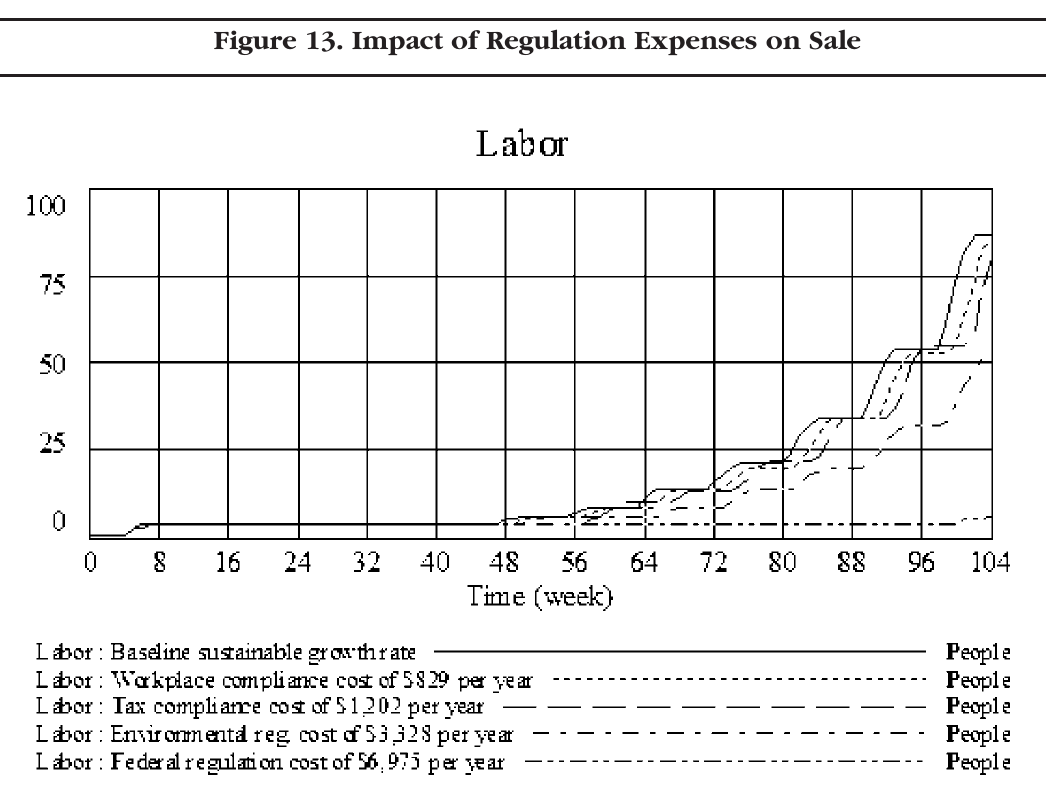
Figure 14. Impact of Regulation Expenses on